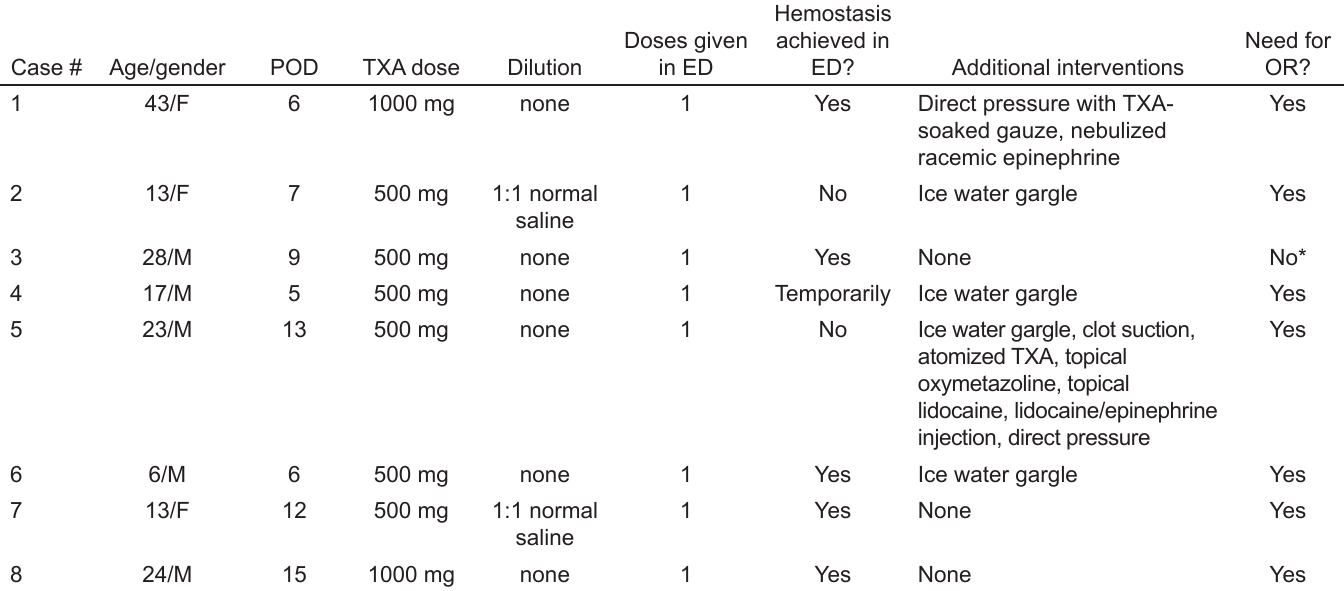
*Patient had previously required return to the OR on POD four due to postoperative